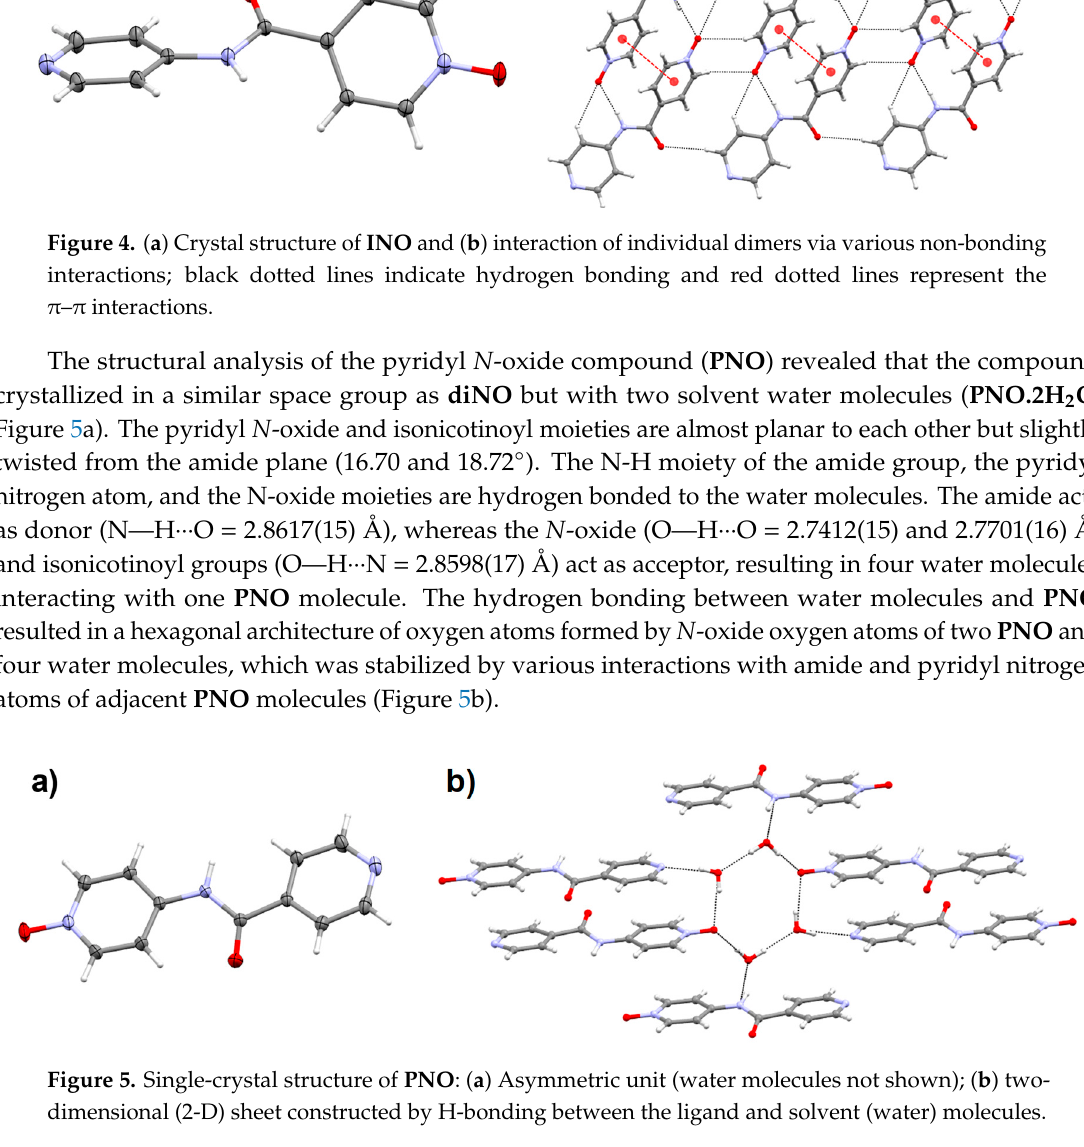
6 of 17 Figure 3. ( a ) Crystal structure of diNO , ( b ) showing hydrogen-bonded dimer stabilized with π – π interaction and ( c ) interaction of the individual dimer with adjacent dimer via various non-bonding interactions (dotted lines); black lines indicate hydrogen bonding, red line for π – π interactions of the individual dimer, and blue line for π – π interactions with adjacent dimers. Compound INO crystalized in a triclinic space group (P ī ) and the twisting of the pyridyl N - oxide ring (58.86°) was similar to diNO (Figure 4a). The hydrogen-bonding pattern was exactly the same as in diNO resulting in a dimer, which was stabilized by N ― H···O and π – π interactions. The only difference between these two structures was the connection between adjacent dimers and the dimer in INO propagates via C ― H···N interaction (3.4391(16) and 3.5489(16) Å), whereas C ― H···O and π – π interactions are observed in diNO . The solvated form of INO was also isolated ( INO.2H 2 O ) and the crystals belong to a monoclinic C2 /c space group (Figure S10). The asymmetric unit contains one INO and two molecules of water, and the isonicotinoyl N -oxide and pyridyl moieties are coplanar to the amide groups compared to the de-solvated form. The hydrogen-bonding pattern of INO.2H 2 O was different from INO due to the presence of dimeric water clusters . The isonicotinoyl N -oxide was hydrogen-bonded to two water molecules via O ― H···O interactions (2.793(3) and